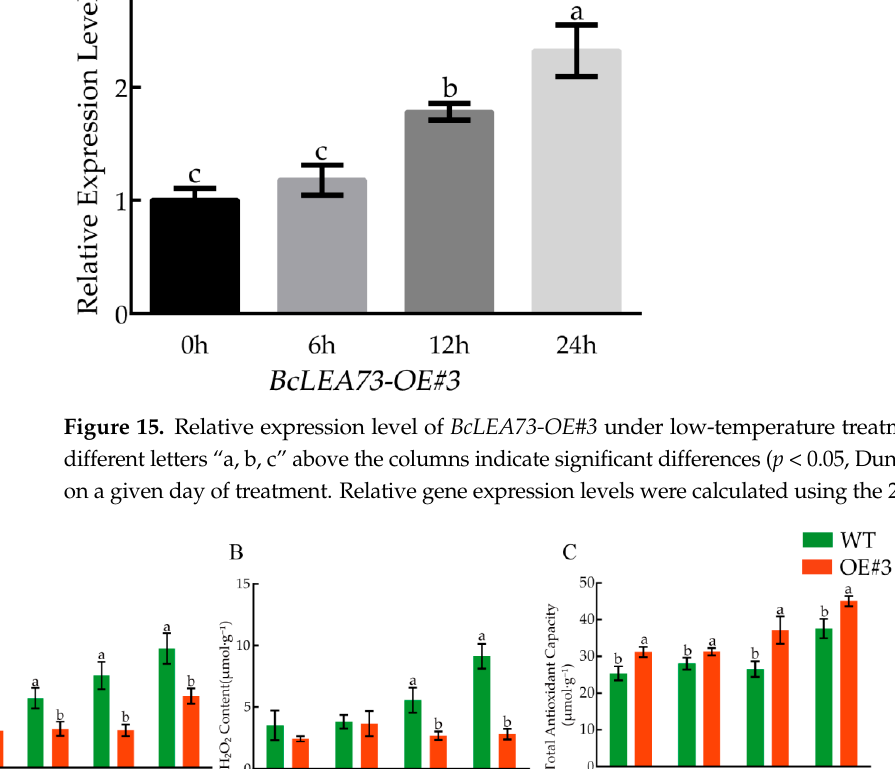
Figure 15. Relative expression level of BcLEA73 ‐ OE#3 under low ‐ temperature treatment. Bars with different letters “a, b, c, d” above the columns indicate significant differences ( p < 0.05, Duncan’s range test) on a given day of treatment. Relative gene expression levels were calculated using the 2 −ΔΔ CT method.